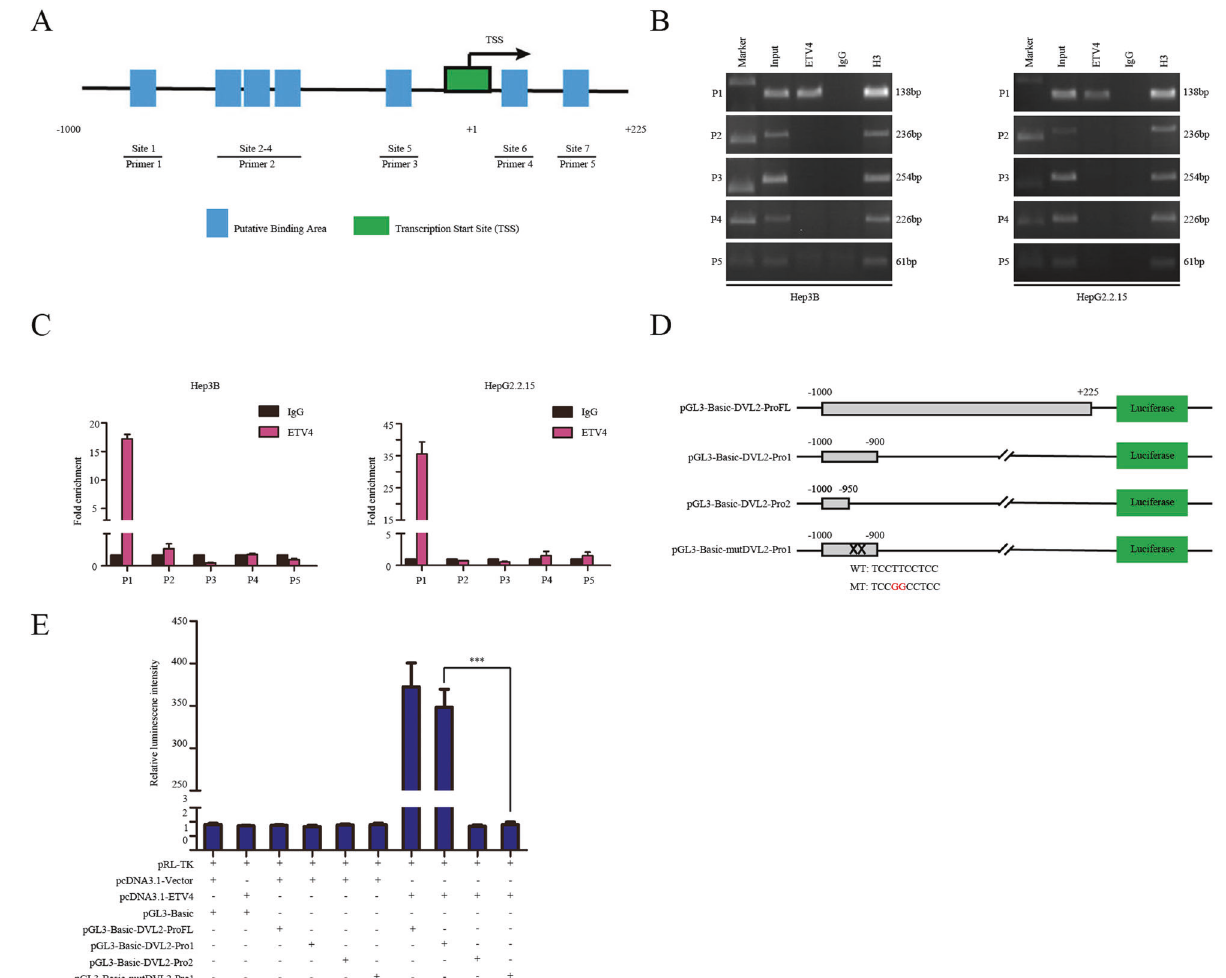
Fig. 6 ETV4 upregulates DVL2 expression and its transcriptional activity by directly binding to the DVL2 promoter. A A schematic representation of the ChIP-PCR and ChIP-qPCR primers designed around the DVL2 promoter region. Seven predicted binding sites were designed to be included in fi ve pairs of primers. B ChIP-PCR assay with ETV4 antibody to validate the direct interaction between ETV4 and the DVL2 promoter region in Hep3B and HepG2.2.15 cells. The results emphasize that ETV4 can bind at site 1 ( − 918 bp to − 909 bp) of the DVL2 promoter region. Cell lysates before precipitation were removed separately as input (1%). IgG was a negative control provided by the kit. H3 was a positive control provided by the kit. C ChIP-qPCR assay with ETV4 antibody to validate the direct interaction between ETV4 and the DVL2 promoter region in Hep3B and HepG2.2.15 cells. The results con fi rm that ETV4 can bind at site 1 ( − 918 bp to − 909 bp) of the DVL2 promoter region. IgG was a negative control provided by the kit. D Schematic diagram of the construction of a dual luciferase reporter gene construct. The DVL2 promoter fragment was inserted into the pGL3-Basic plasmid. ProFL represents the full length of the DVL2 promoter region, Pro1 represents − 1000 bp to − 900 bp, Pro2 represents − 1000 bp to − 950 bp, and mutPro1 indicates that Pro1 has been